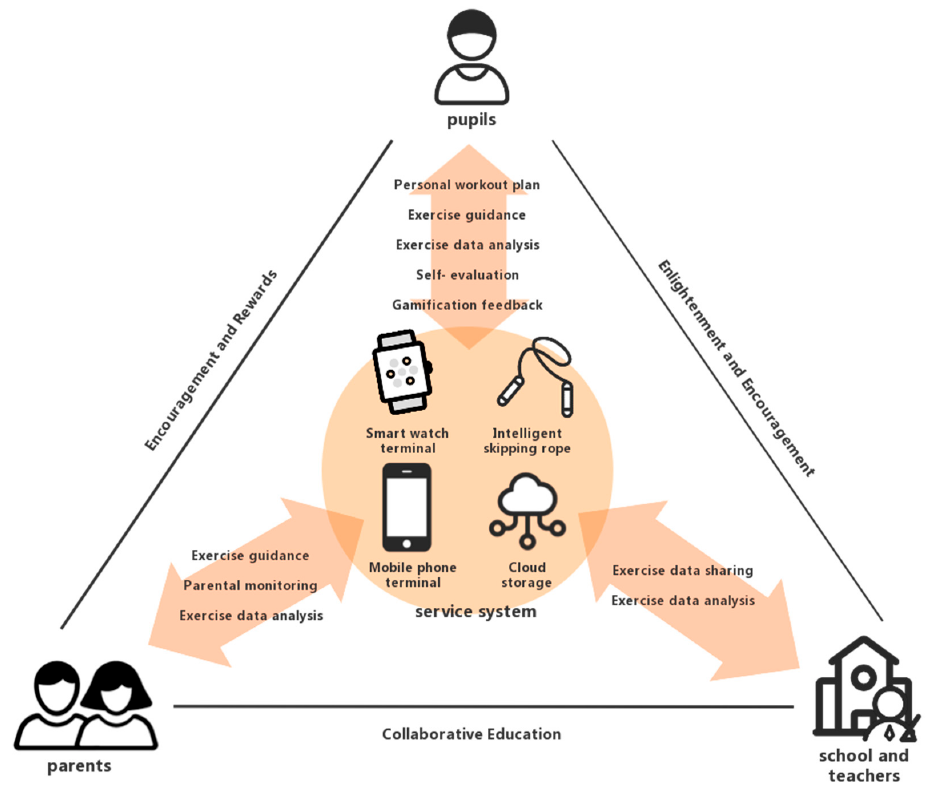
Figure 3. Service framework of the intelligent skipping rope system.